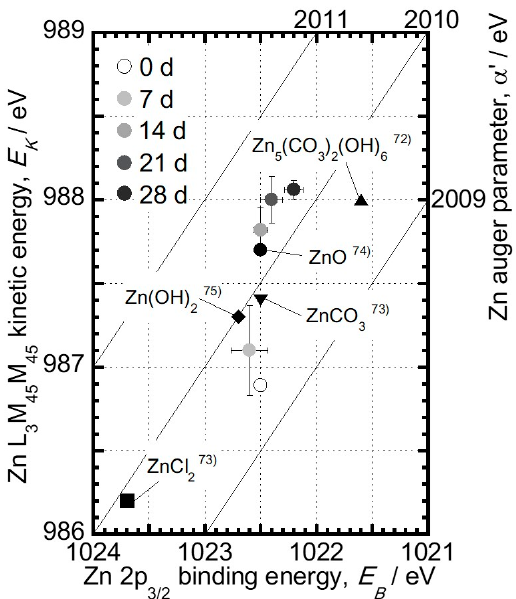
Figure 4. Wagner plot of Zn in the oxide layer incubated for 0–28 days based on Zn 2p 3/2 photoelectron peaks and Zn L 3 M 45 M 45 Auger peaks ( n = 3). Each parameter of Zn 2+ compounds were plotted according to previous studies [72–75].